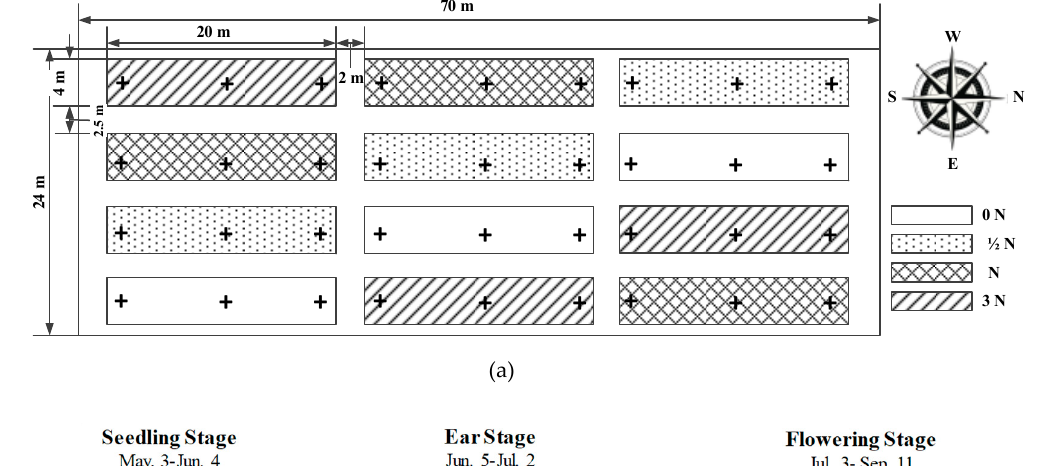
Table 1. Soil sample information.